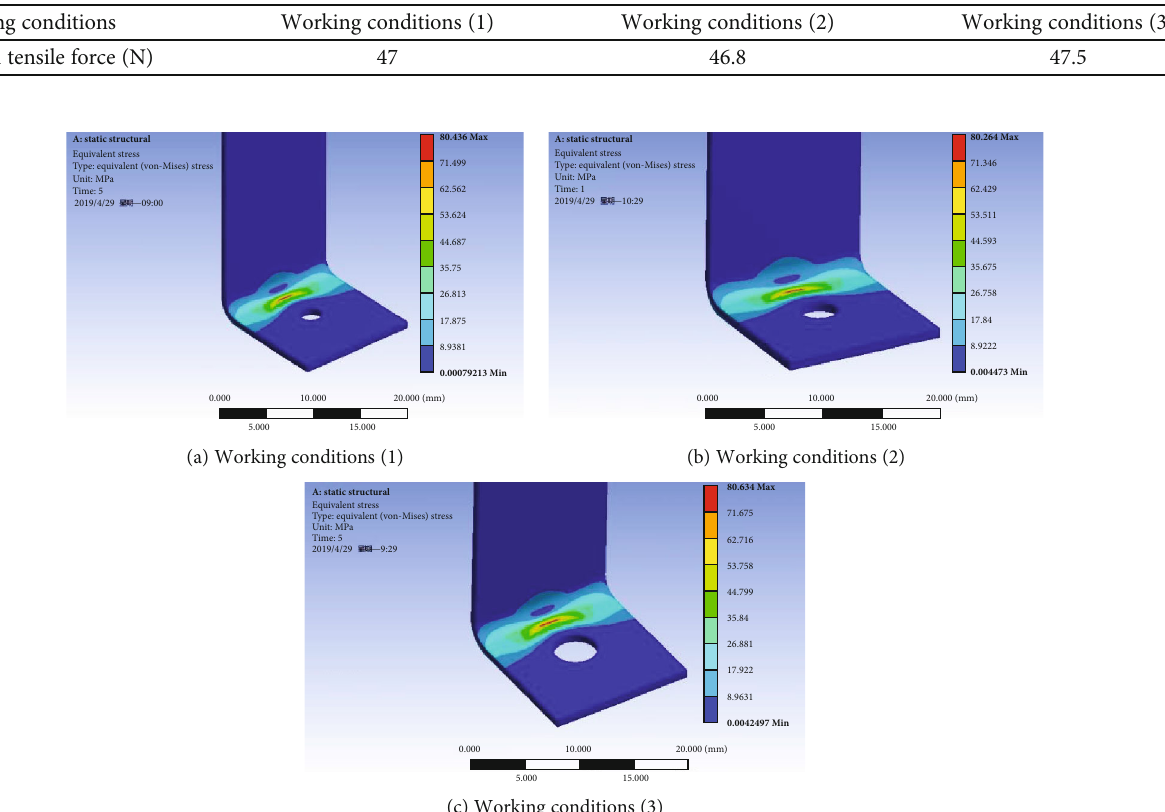
Figure 16: Three fi nite element model of riveting hole opening condition ( fi xed bolt hiding). Table 4: The critical tensile force of nylon ribbon corresponding.